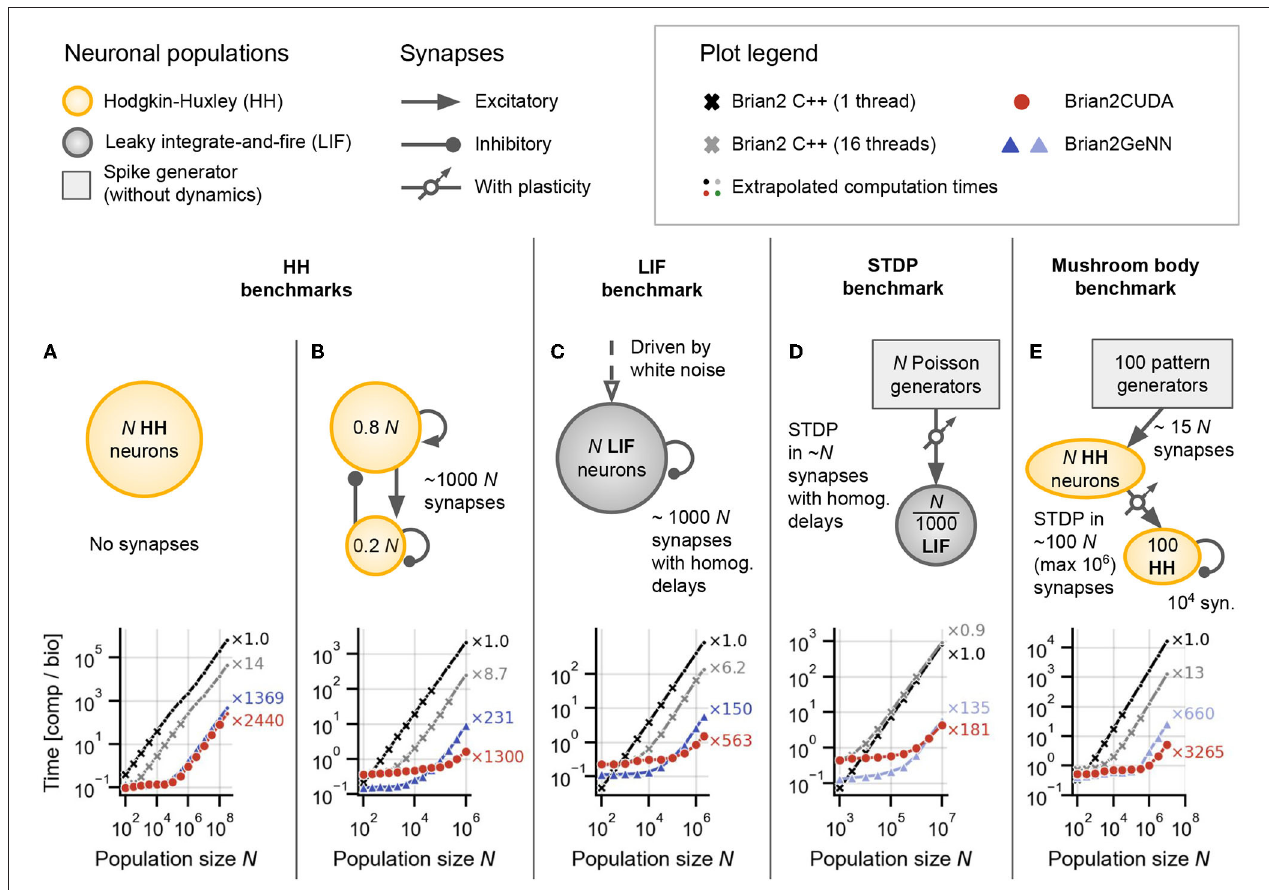
FIGURE 5 | Benchmark results for networks without delays or with homogeneous delays. (A) Hodgkin-Huxley (HH) population without synapses. (B) Sparsely coupled recurrent HH network with 80 % excitatory and 20 % inhibitory neurons, without synaptic delays. (C) Leaky integrate-and-fire (LIF) network with sparse random connectivity and homogeneous synaptic delays d ij ≡ d = 2ms for all synapses. (D) Spike-timing dependent plasticity (STDP) benchmark with homogeneous delays d ij ≡ d = 2ms. (E) Mushroom body benchmark with non-plastic synapses in the first layer and synapses with STDP in the second layer, both randomly connected and without delays. For all panels: The text annotations on the right of the axes show the factor by which each simulation was faster than